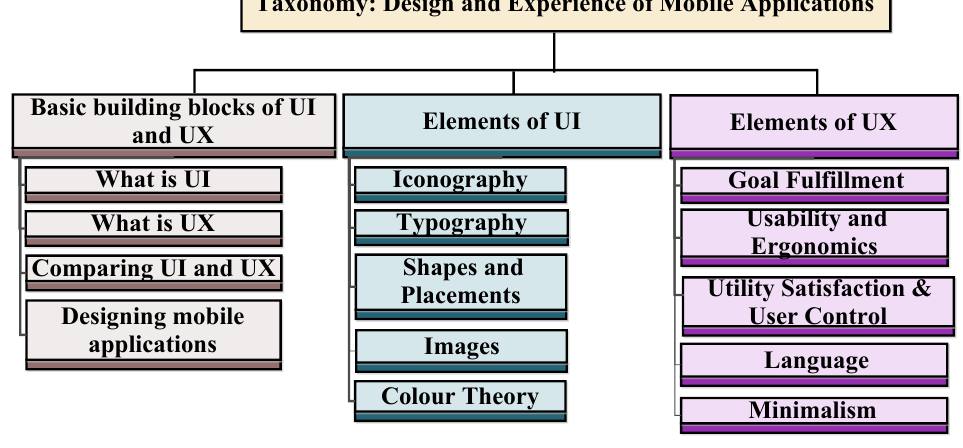
Figure 3. Taxonomy: design and experience of mobile